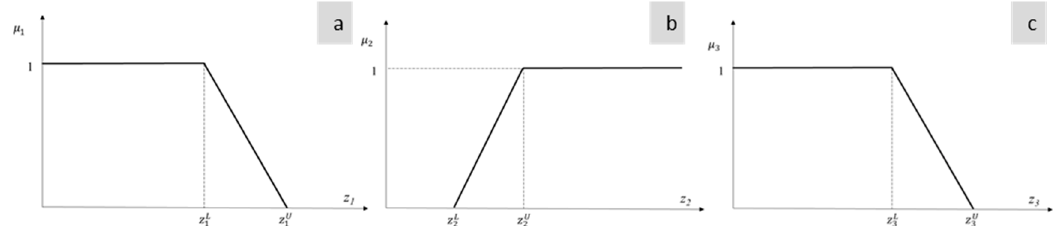
Figure 2. Membership curves for the objective functions for µ 1 ( a ), µ 2 ( b ), and µ 3 ( c ) (adapted from [46–49]).